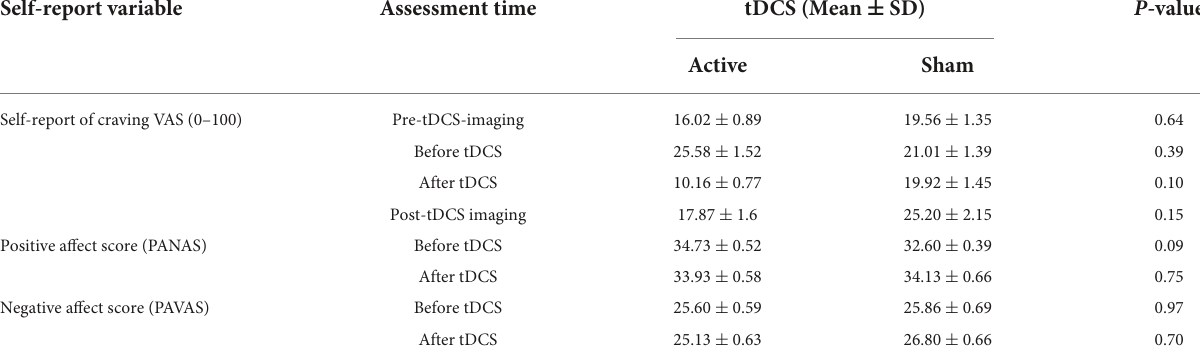
TABLE 4 Self-report